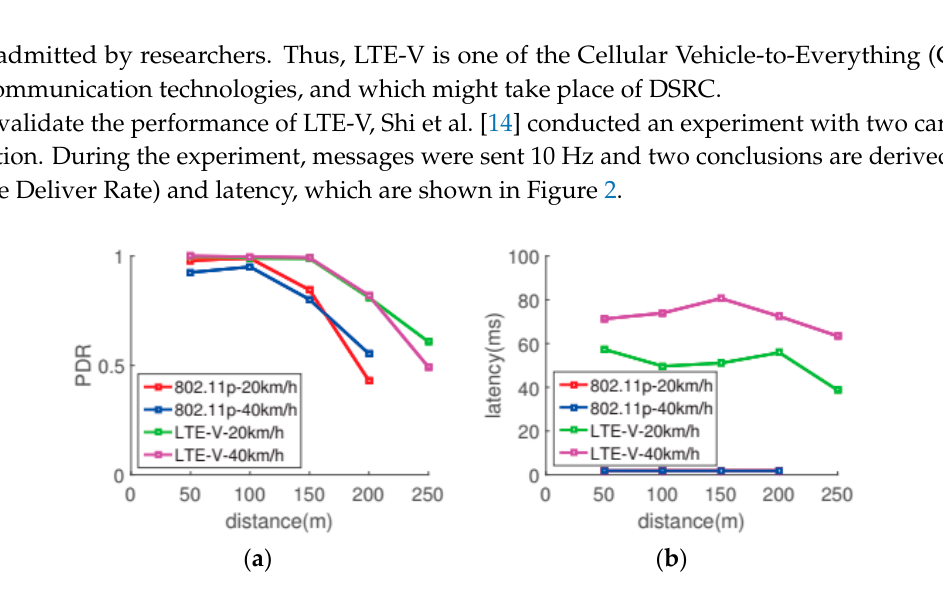
Figure 2. Experiment results at intersection: (a) Package Deliver Rate (PDR); (b) Latency of DSRC.